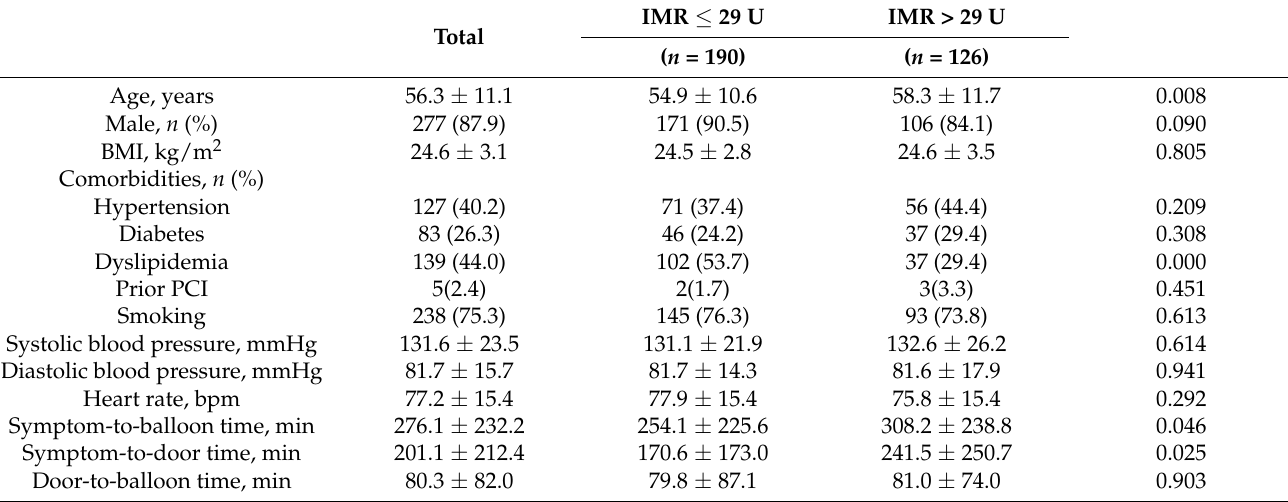
Table 1. Baseline clinical characteristics, laboratory findings, and echocardiographic